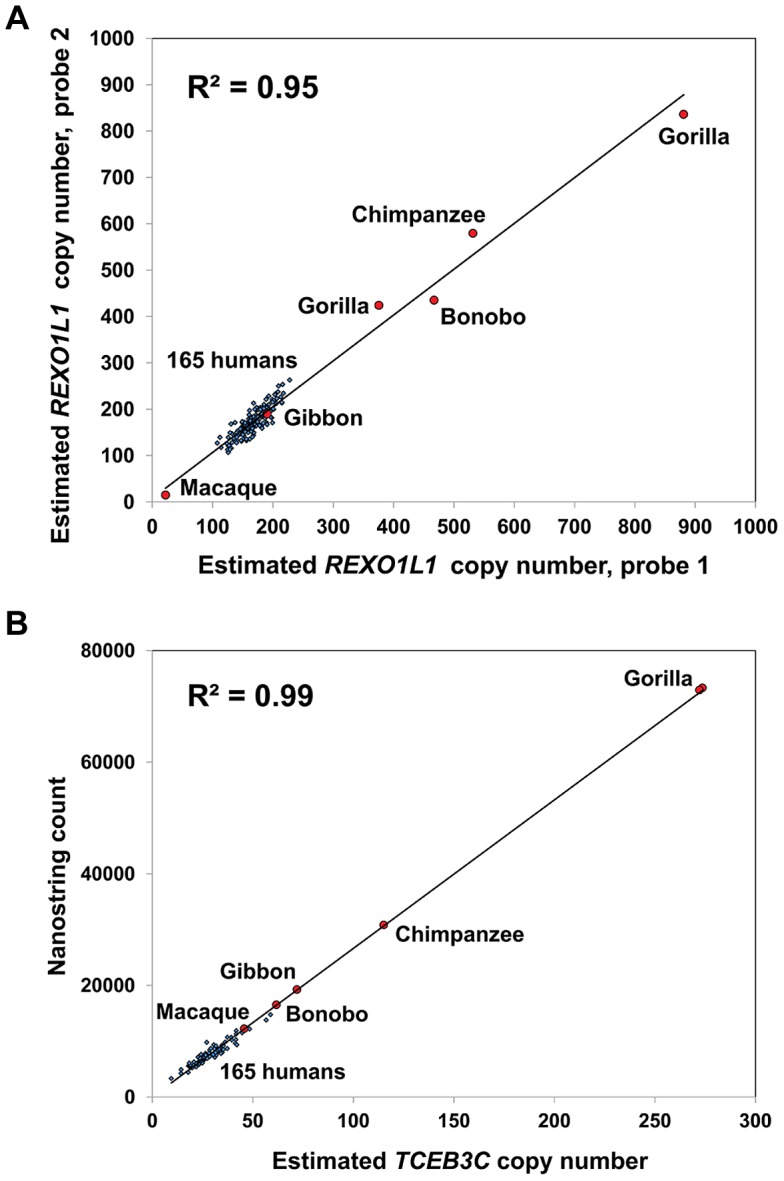

REXO1L1 and TCEB3C show extreme variation in copy number among primate species.(a) REXO1L1 is one of the most extreme examples of copy number variable genes in human, with 108–266 copies of the ∼12.2 kb repeat unit observed in the 165 HapMap individuals studied. However even more extreme variation is observed among different primates. We observed ∼450 and ∼550 copies in bonobo and chimpanzee, respectively, and copy numbers of ∼400 and ∼860 in two different gorilla individuals. In contrast while macaque has an estimated 22 copies, gibbon falls within the same range seen in human. (b) While TCEB3C ranges from 9–59 copies among HapMap individuals (mean 29 copies), all five species of primate studied show increased copy number, indicating a reduction of TCEB3C copy number specifically in the human lineage. As with REXO1L1, gorilla and chimpanzee showed the highest copy numbers, with 115 in chimpanzee and ∼270 copies in both gorillas studied.